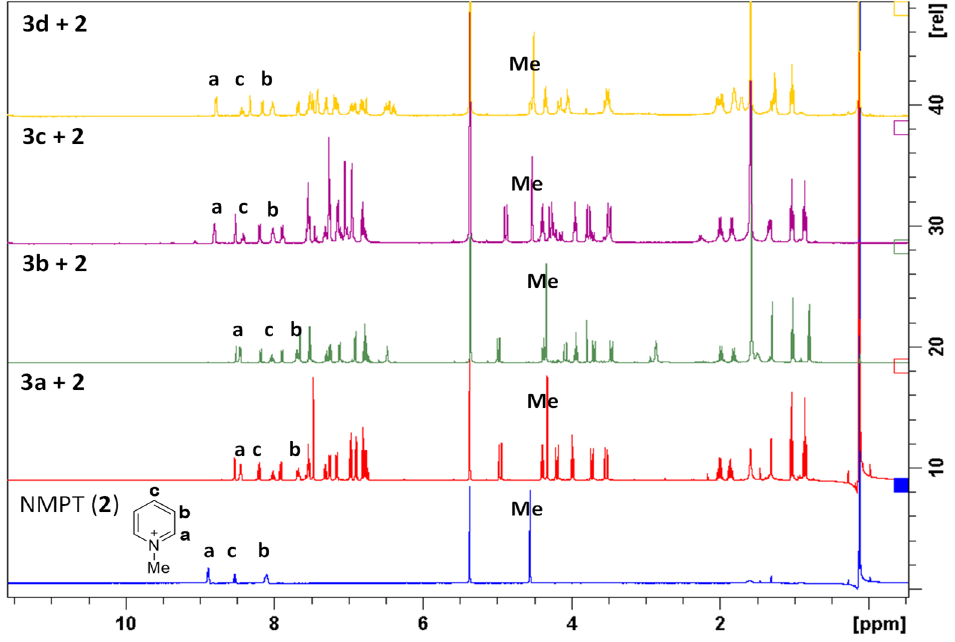
Table 2. Comparative studies of the 1 H NMR chemical shifts ( δ , ppm) of 2 within the calixarene cavities (CD 2 Cl 2 , 5 mM).